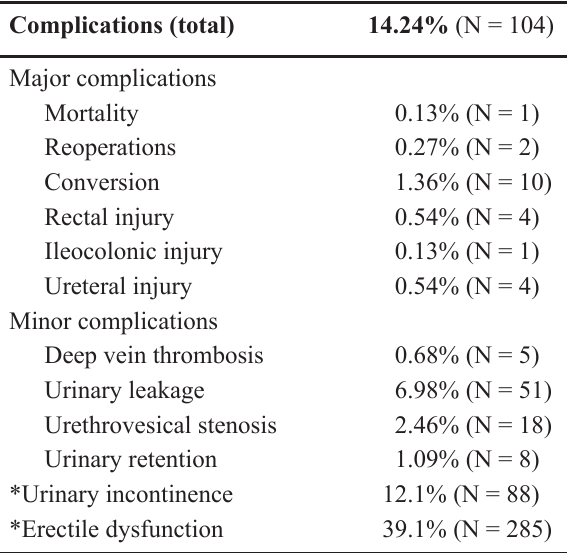
Table 2 – Complication rates and results for laparoscopic radical prostatectomy.